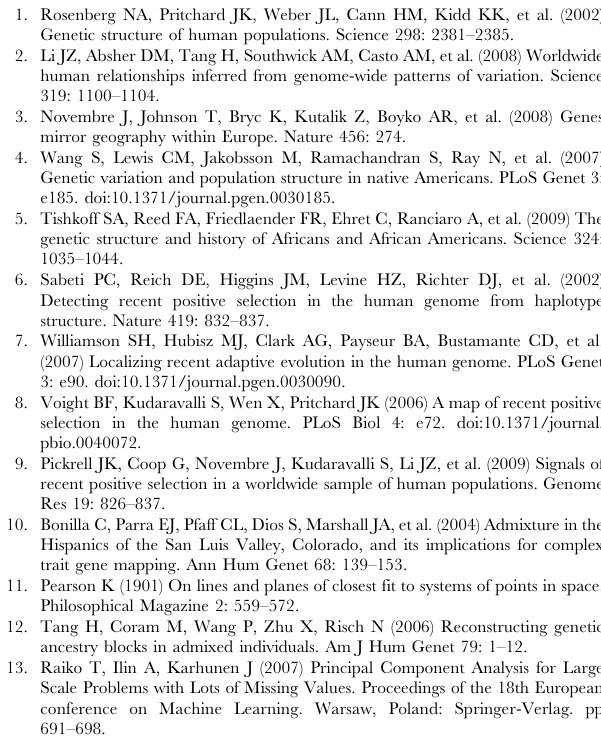
Figure S1 Comparison of genome-wide ancestry proportions estimated by frappe and by averaging SABER + locus-specific